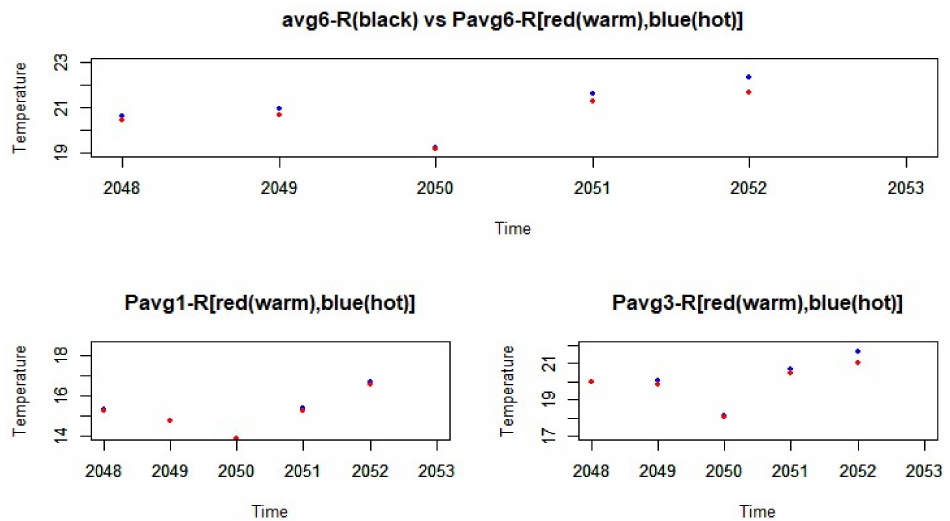
Figure 38. RCP 4.5 warm model (IPSL-CHEM-MR) and RCP 4.5 hot model (MIROC-ESM-CHEM) predictions for the period 2048–2053 (recorded water level), temperature in ◦ C.